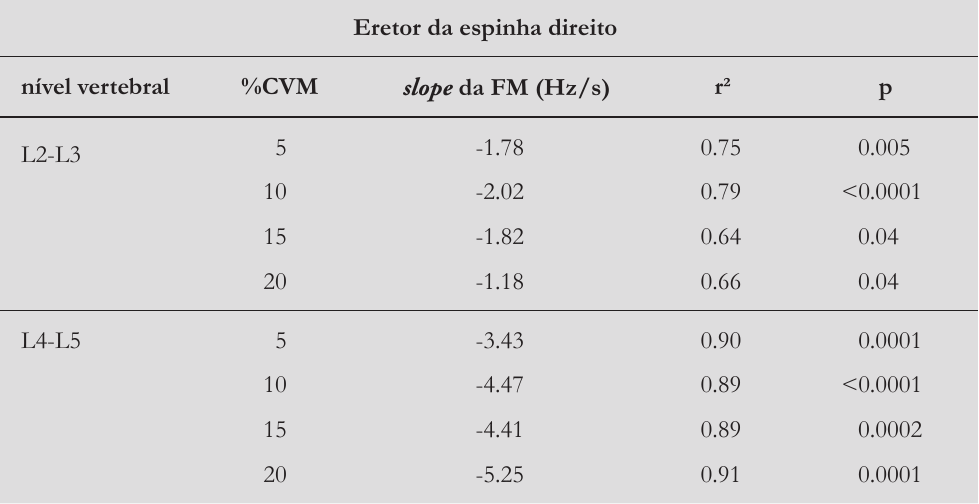
Tabela 1 - Valores médios dos slopes de FM e seus respectivos dados estatísticos Eretor da espinha direito nível